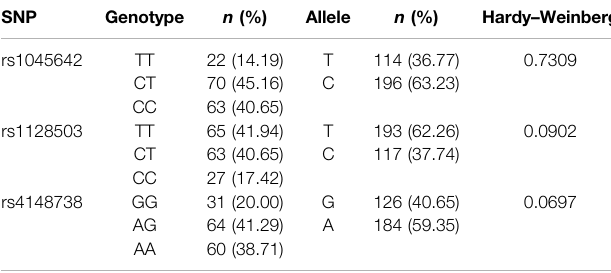
TABLE 1 | General data of Rivaroxaban recipients ( n (cid:1) 155). Variables Total number of Men